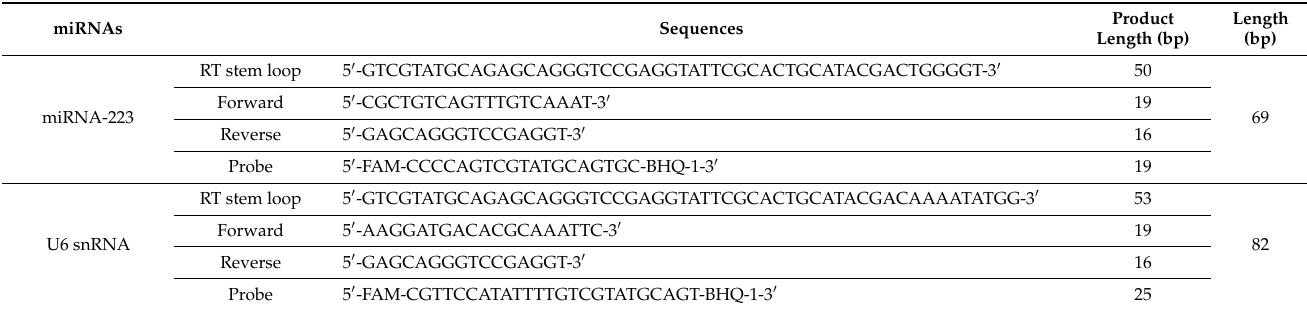
Table 1. Sequence of primers and probes used to evaluate the expression of